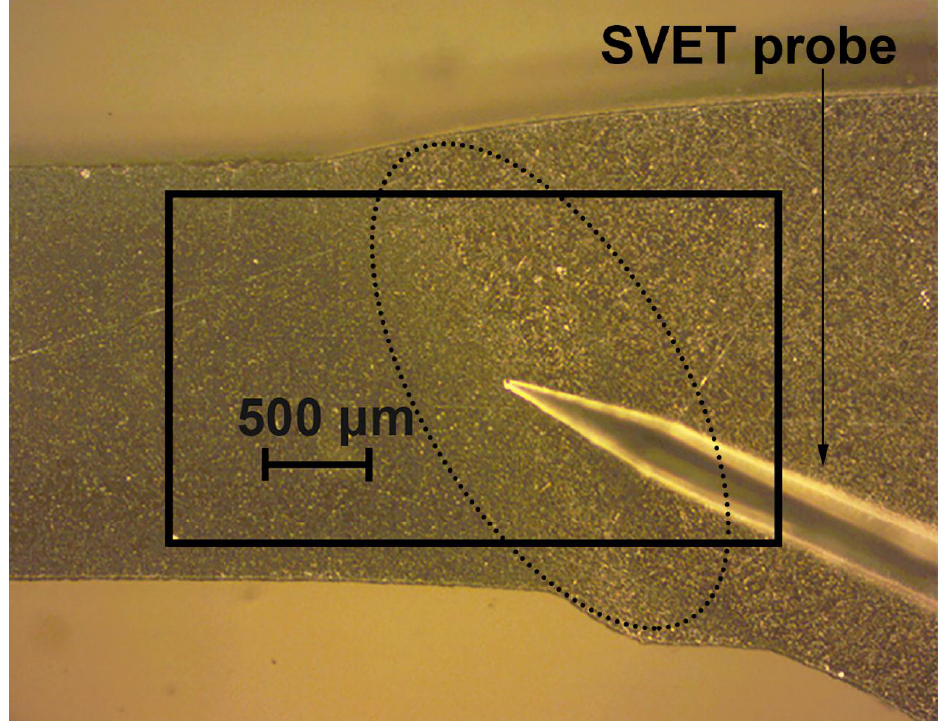
Figure 7. The image obtained by optical microscopy of the investigated area of the welded 1579 aluminium alloy sample before the SVET experiment for corrosion. The investigated area is outlined by a frame and the border of the weld interface of the aluminium alloy is marked by a dotted line. Low corrosion activity was registered by the SVET over the whole surface under study after 1.5